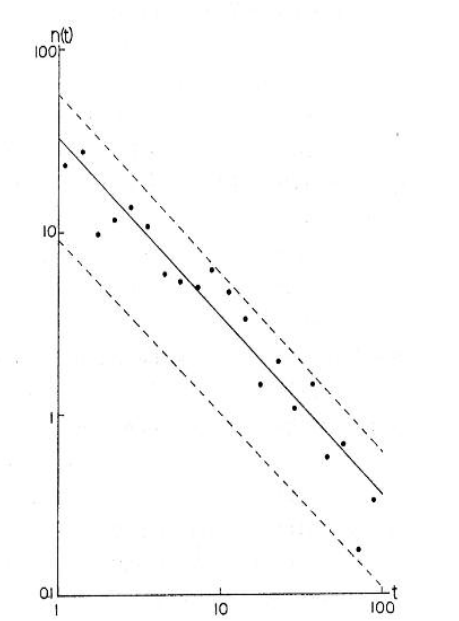
Figure 2. Time distribution of aftershocks: Aleutian Islands 1957. Figure 3. Time distribution of aftershocks: Kern County 1952.